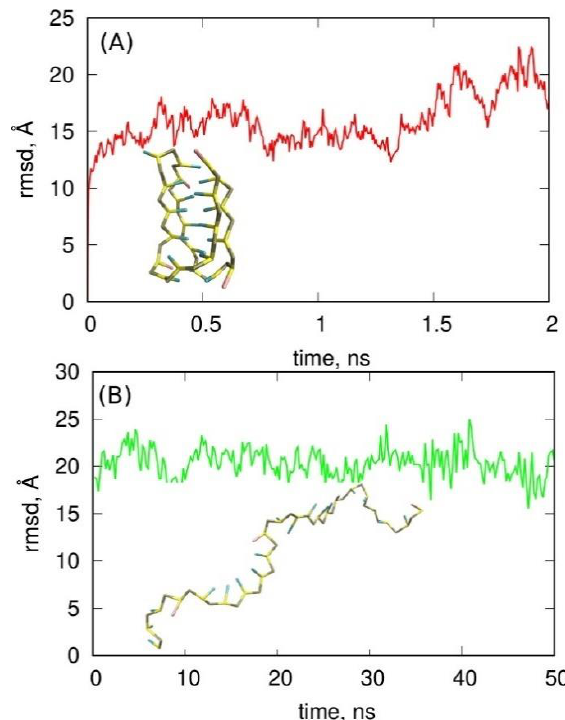
Figure 7. ( A ) Root-mean-square displacement (rmsd) of the analyzed structure from the ideal i-motif form in 3SPN representation (inset). ( B ) The rmsd from the ideal i-motif form but calculated for the single-stranded DNA fragment in the ideal coiled form. The snapshot in ( B ) shows the average final structure obtained from both ( A , B )